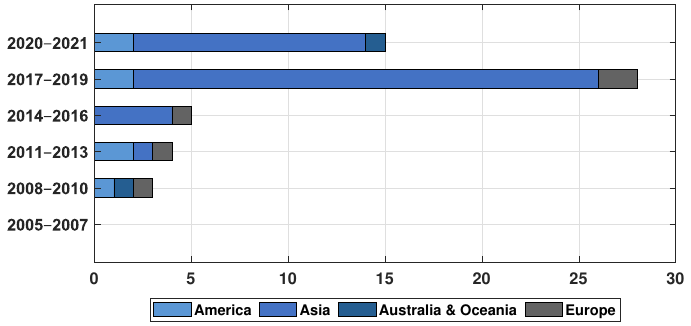
Figure 6. Development by